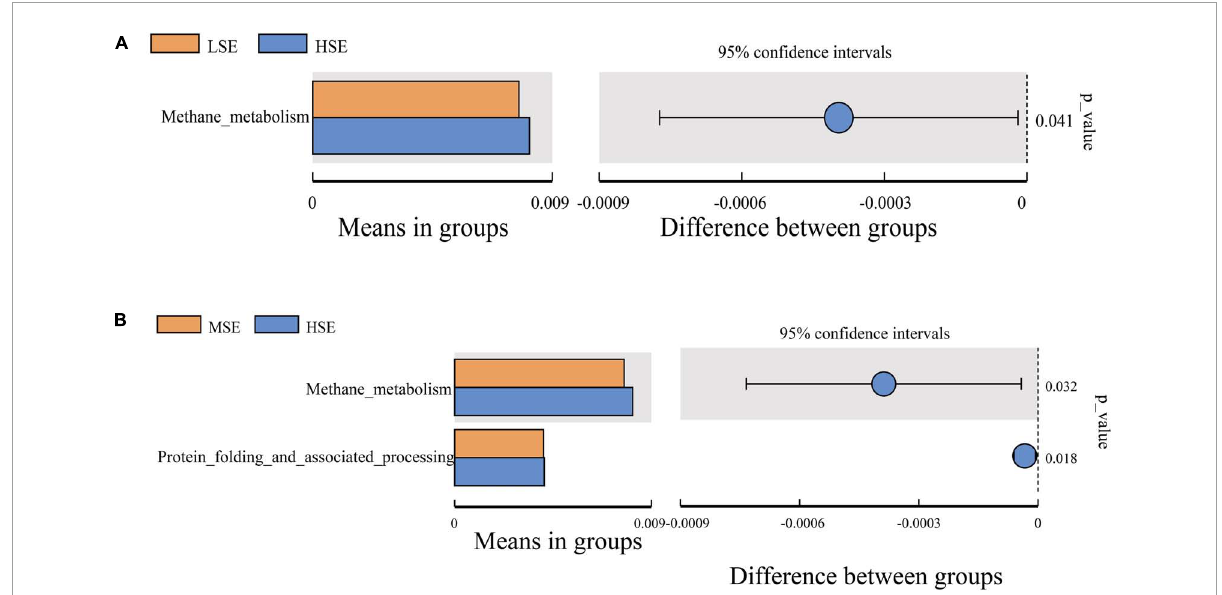
FIGURE9 Comparison of the enrichment of KEGG pathway level 3 between LSE and HSE group (A) , MSE and HSE group (B)